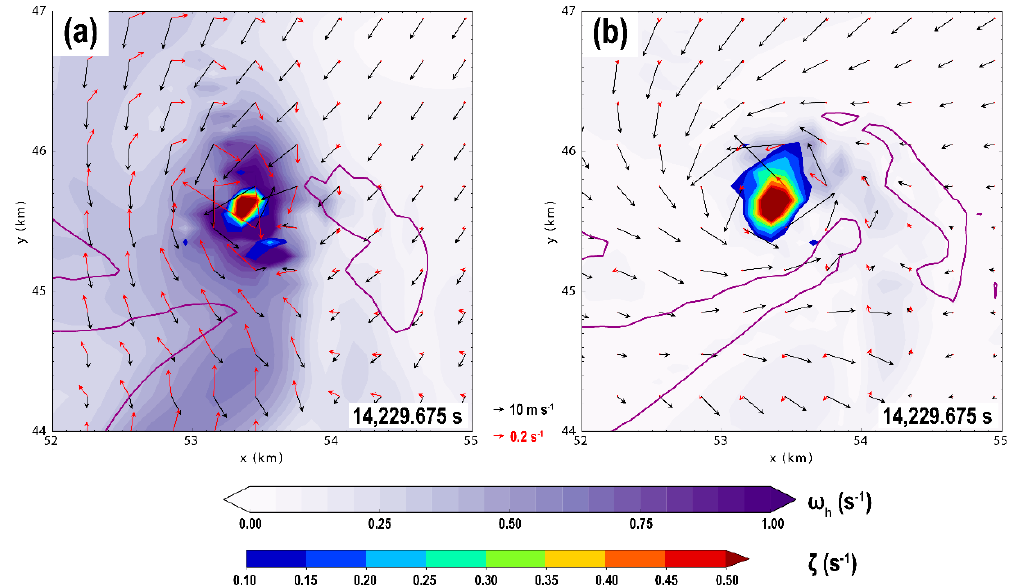
Figure 8. Horizontal vorticity (magnitude is light shaded and vectors are red; in s − 1 ) centered at the tornado at ( a ) 1 m AGL and ( b ) 158 m AGL valid at 14,229.675 s (during the intensification phase of the tornado). Horizontal wind vectors are in black (in m s − 1 ) and vertical vorticity ζ is shaded in the foreground, starting at 0.1 s − 1 . The purple line indicates the 0.3 g kg − 1 rainwater mixing ratio isopleth.